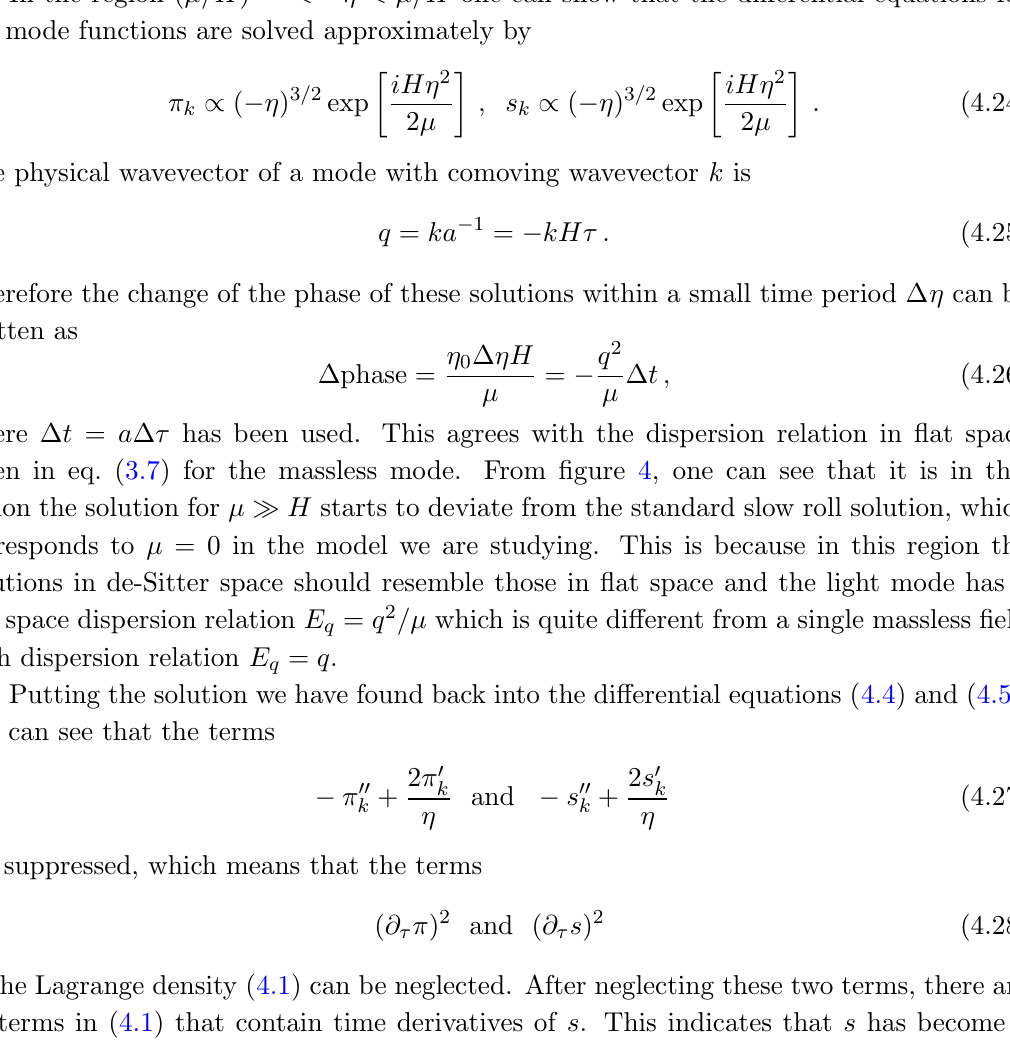
Figure 4 . Numerical result of P (cid:25) ( k ) as a function of (cid:17) in the unit of H 2 = (2 k 3 ) for m = 0 and (cid:22) = 100 H . For comparison in blue we show the result for standard single (cid:12)eld in(cid:13)ation. In the region ( (cid:22)=H ) 1 = 2 < (cid:0) (cid:17) < (cid:22)=H one can show that the di(cid:11)erential equations